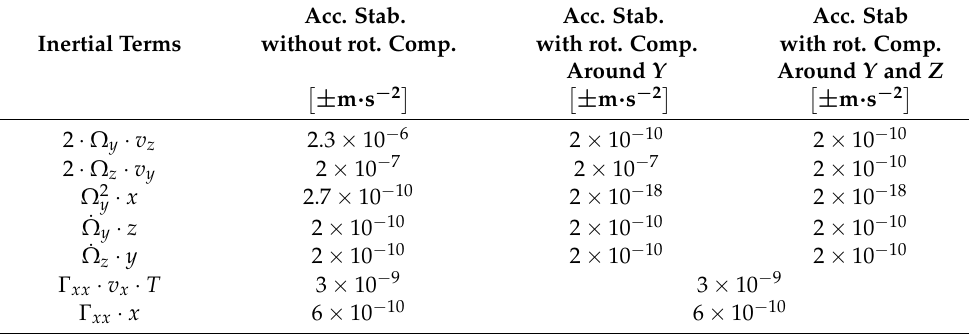
Table 4. Estimation of main errors coming from the coupling of the atomic source kinematics with the satellite rotation and the Earth gravity gradient. The estimations with rotation compensation are given considering a satellite rotation compensation with a residual at a level of 100